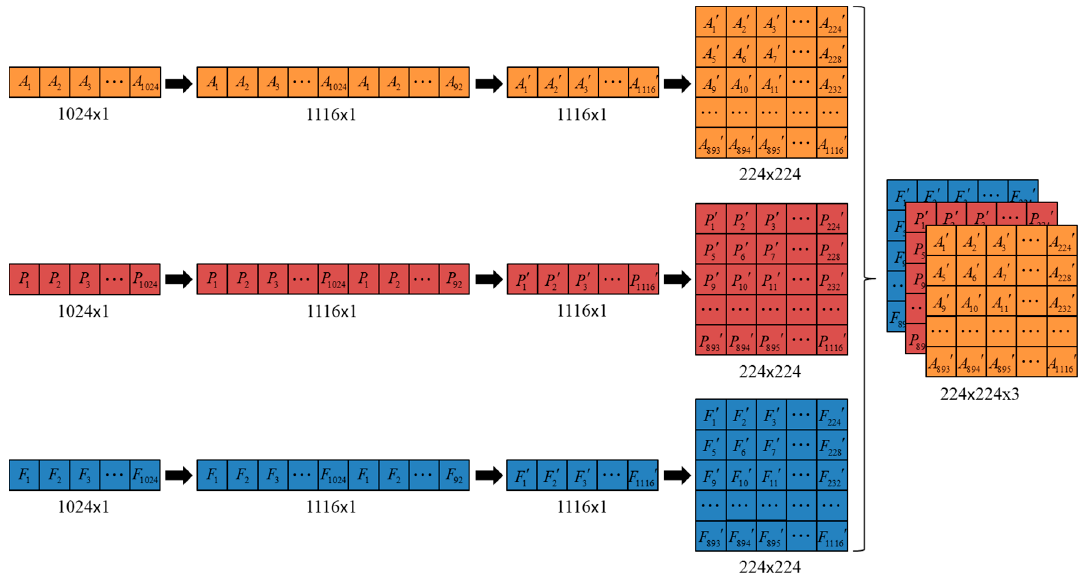
Figure 2. Schematic diagram of the signal rearrangement method. In the figure, 𝑁 = 1024 , 𝑊 = 224 , 𝐿 = 4 . The instantaneous amplitude, instantaneous phase and instantaneous frequency of the input all contain 1024 elements. First, each input sequence is expanded to a vector with a length of 1116, and then it is transformed into a matrix of 224 × 224 by sliding. Finally, the three matrices are spliced to obtain an image of 224 × 224 × 3, whose size is consistent with the size of images in ImageNet.